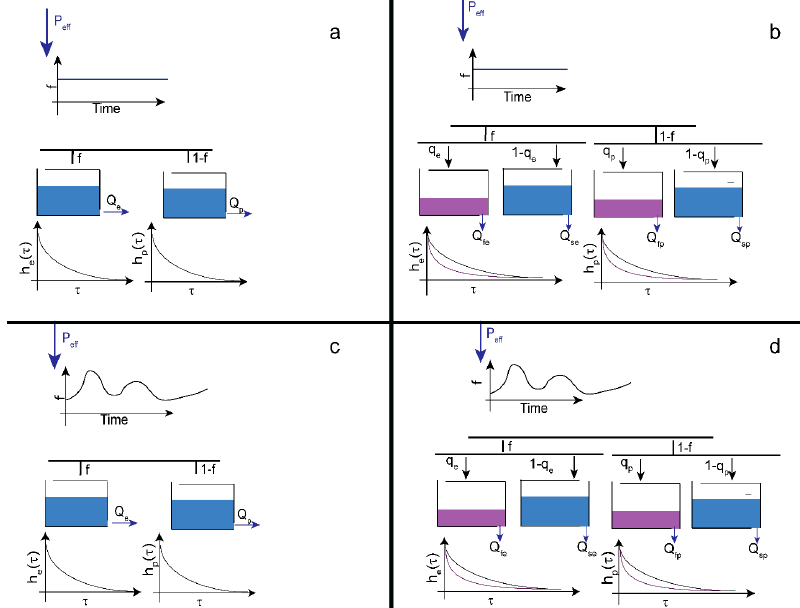
Figure 2. Assumptions in TRaSPAN model structures ( a ) constant fraction of effective precipitation ( P eff ) routed as event water and a single reservoir for the event and pre-event runoff components (structure 1); ( b ) constant fraction of P eff routed as event water and two reservoirs in parallel for the event and pre-event runoff components (structure 2); ( c ) time-variable fraction of P eff routed as event water and a single reservoir for the event and pre-event runoff components (structure 3); and ( d ) the time-variable fraction of P eff routed as event water and two reservoirs in parallel for the event and pre-event runoff components (structure 4).